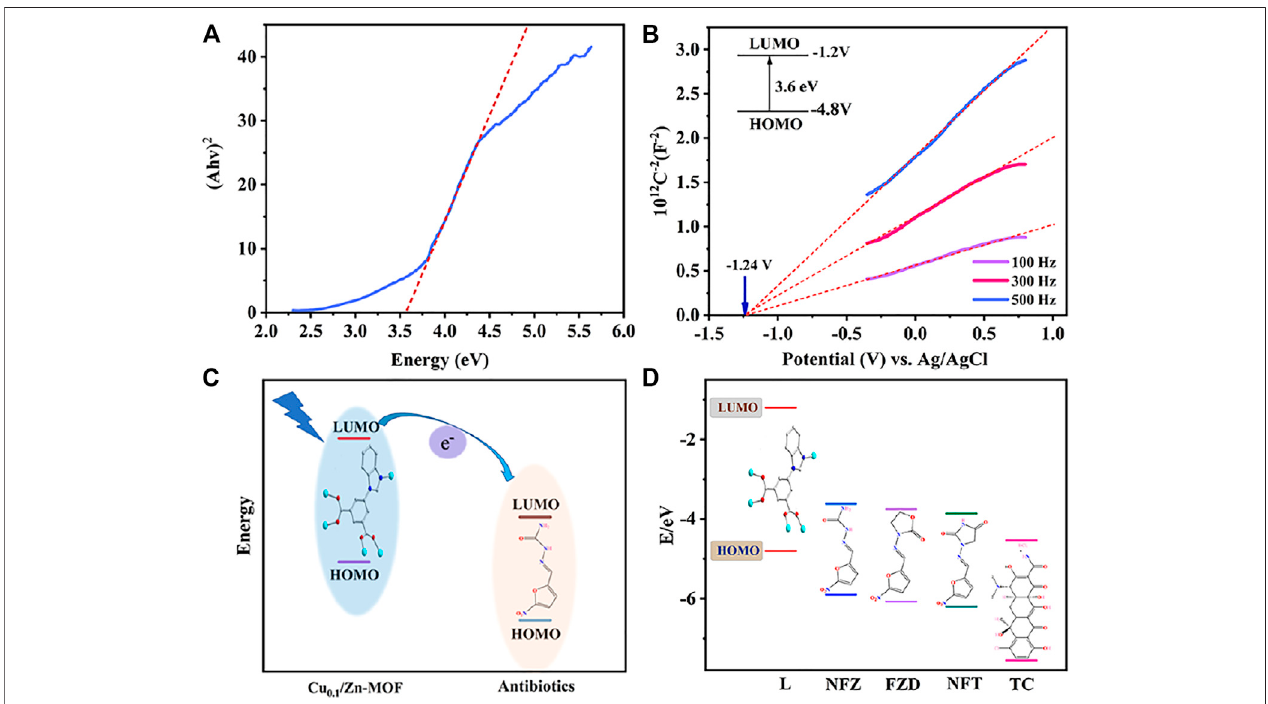
FIGURE6|(A) Kubelka – MunkplotsofCu 0.1 /Zn-MOF. (B) Mott – SchottkyplotsofCu 0.1 /Zn-MOF. (C) SchematicofelectrontransferfromtheLUMOofMOFstothe LUMO of antibiotics. (D) Theoretical HOMO and LUMO energies for selected